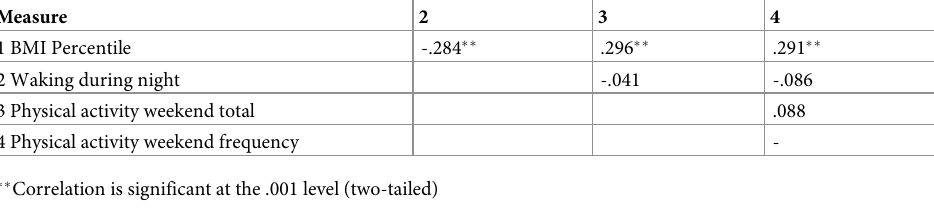
Table 9. Spearman’s Rho correlations for control group BMI